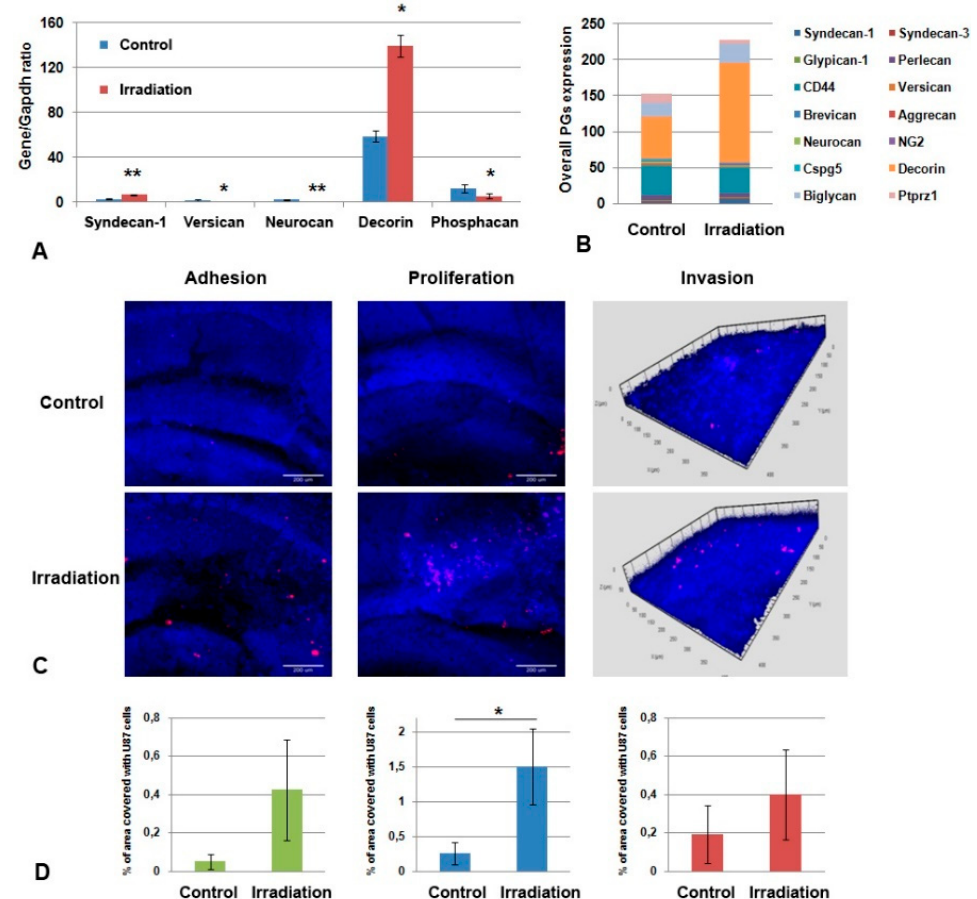
Figure 7. Co-culture of organotypic brain tissue slices ex vivo with GBM cells. ( A ) Effects of multiple irradiation on PGs’ expression in brain tissue. Real-time RT–PCR analysis, intensity of the amplified DNA fragments normalized to that of Gapdh , bars represent the mean ± SD from triplicate experiments, Student t-test (OriginPro 8.5). ( B ) Overall transcriptional activity of PG core protein-coding genes in brain tissue from control and irradiated mouse brains. The stacked columns compare the contribution of each value to a total across categories. ( C ) Confocal microscopy of U87-RFP cells seeded on the control and irradiated brain slices. Cells nuclei are stained with DAPI. Scale bar 500 µ m. ( D ) Quantitative analysis of the U87-RFP cells on the control and irradiated brain tissues. ANOVA and post-hoc Fisher’s LSD test, * p < 0.05, ** p <